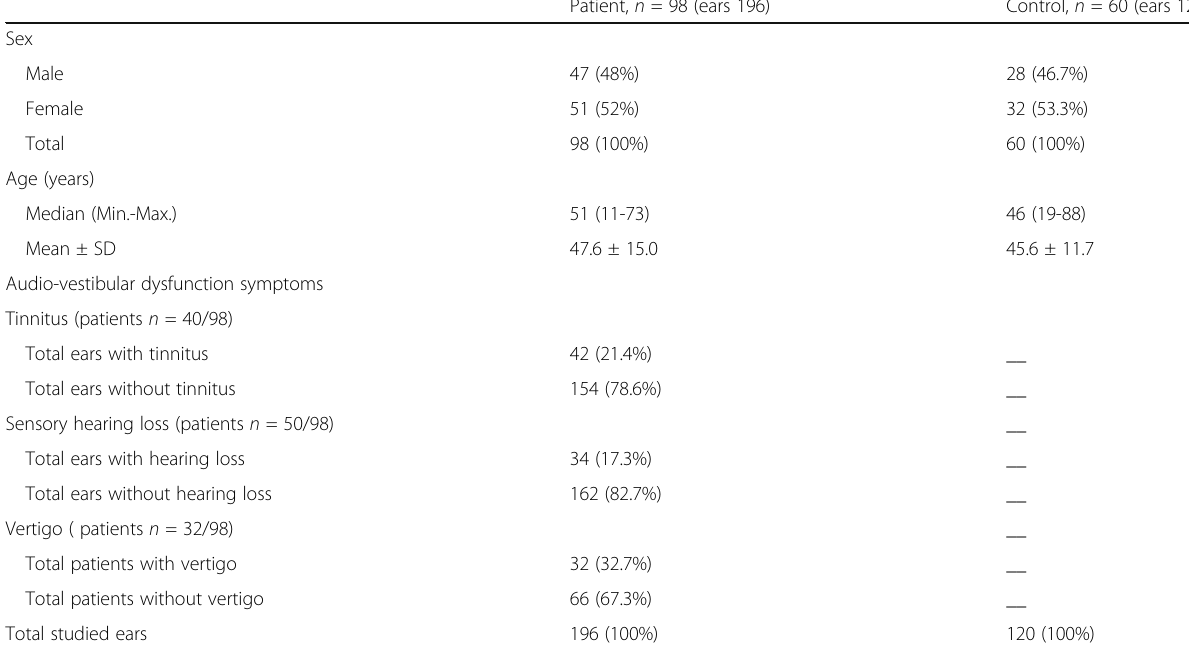
Table 1 Distribution of the studied groups according to demographic data and audio-vestibular dysfunction